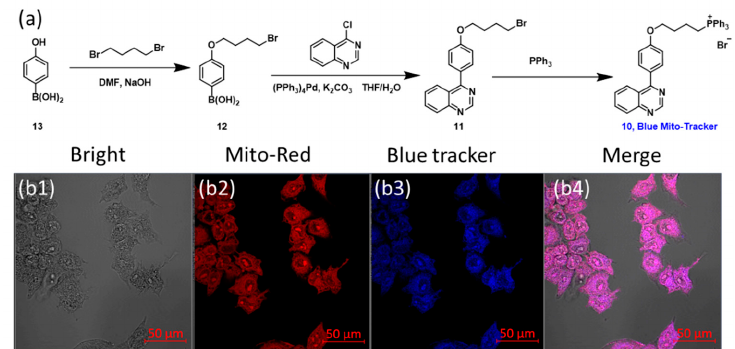
Figure 4. The synthesis of the self-made blue mitochondrial tracking dye (compound 10 ) ( a ) and the colocalization effect of the self-made dye and commercially available MitoTracker Red ( b1 – b4 ). The Pearson’s R value of the red channel and blue channel was 0.91. Scale bar, 50 μ m.